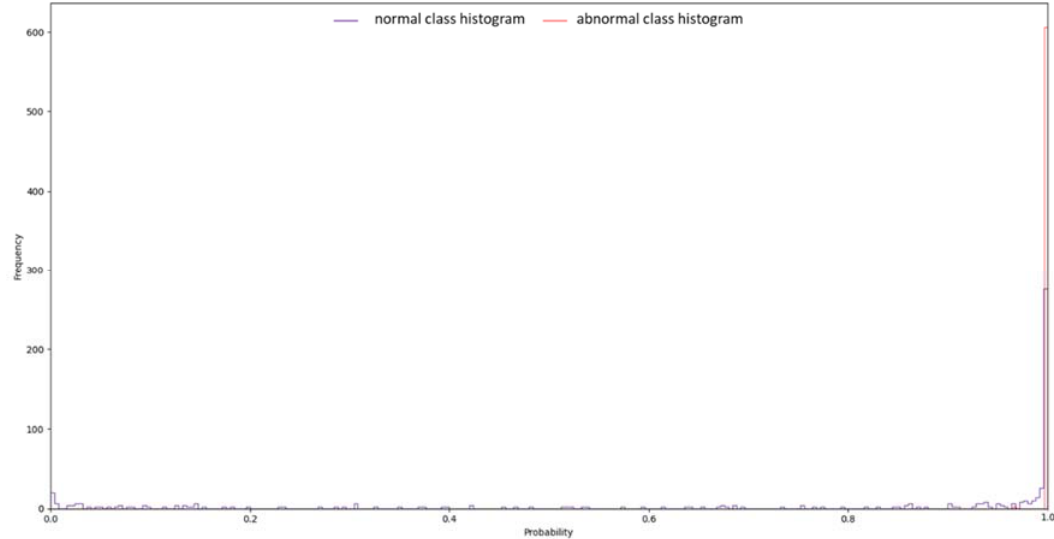
Figure 11. Distribution of abnormal prediction rates for all individual data of the VGG16-PRETR model using preprocessed images.